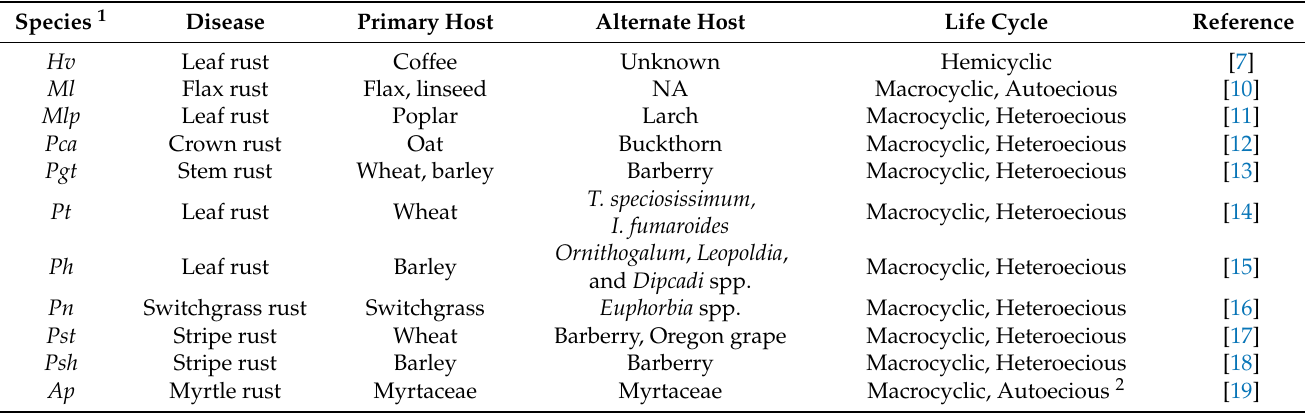
Table 1. General biology of rust pathogens with genomes